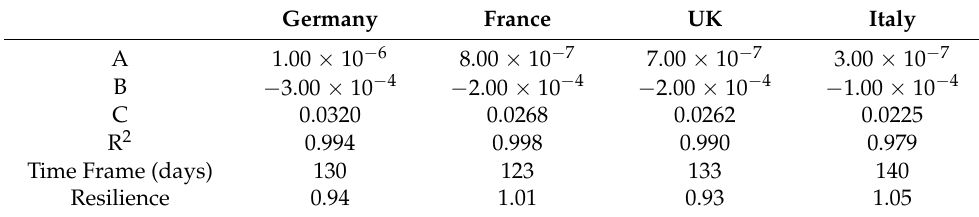
Table 1. Interpolation